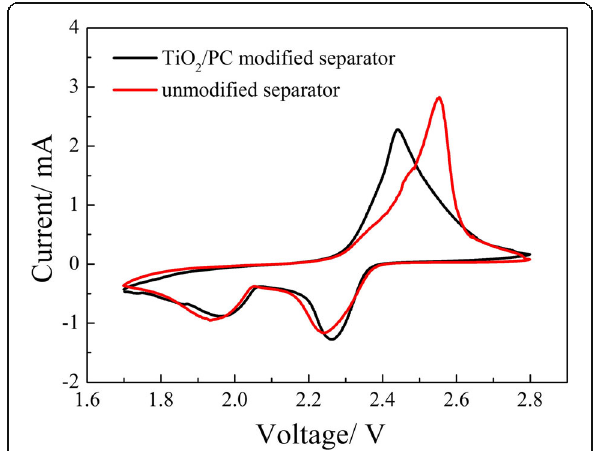
Fig. 7 CV curves of the cells with and without TiO 2 /PC-modified separator